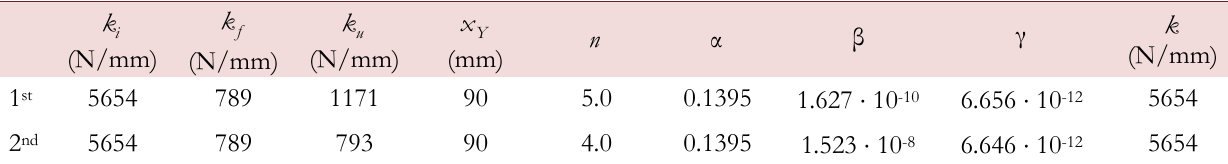
Table 1: BW model parameters